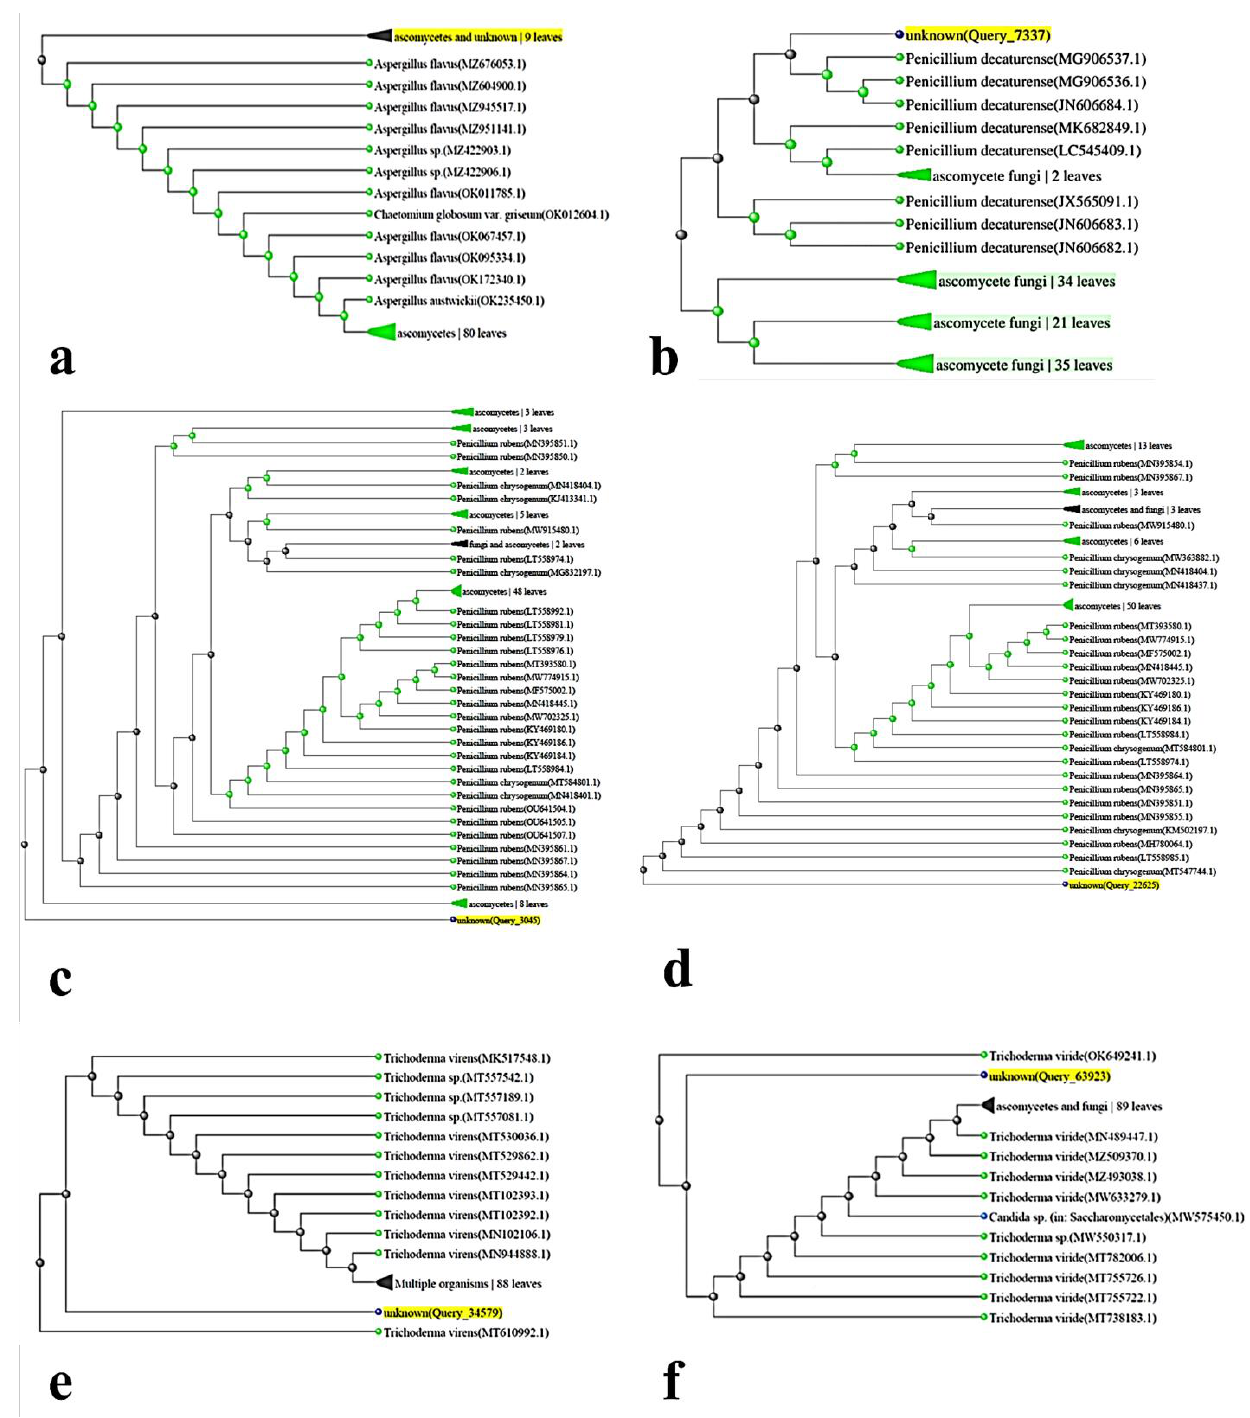
Figure 3. Phylogenetic trees resulting from the ITS-rDNA sequence analysis by the neighbor-joining method represent the location of the searched isolate in the vicinity of the cluster related to: ( a ) Aspergillus flavus , ( b ) Penicillium decaturense , ( c ) Penicillium rubens (MN395851.1), ( d ) Penicillium rubens (MN395854.1), ( e ) Trichoderma virens , ( f ) Trichoderma viride .